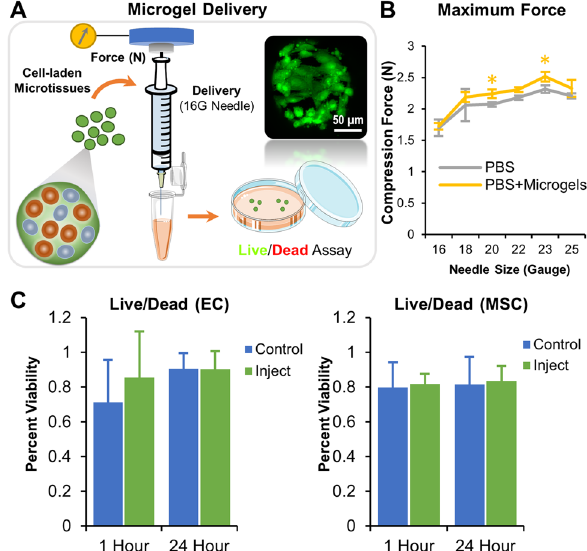
Figure 9. Injectability of cell-laden microgels. ( A ) Test of injectability for microgels. The injection force measurement setup containing an Instron Universal Testing machine equipped with a 10 N load cell measured the compression force. (Inset micrograph) Live human umbilical vein endothelial cells, stained with Calcein AM, on the surface of a microgel that was passed through a 16 gauge needle (n = 5). ( B ) The injection force measurements of acellular microgels using a hypodermic needle of various sizes showed no significant difference compared to the PBS controls.* p = 0.013 (20 gauge) and 0.003 (23 gauge). ( C ) The viability of the EC and MSC, 1 and 24 h post-injection, showed no significant change in viability compared to non-injected controls (n = 12). (Parts of the figure were drawn by using pictures from Servier Medical Art. Servier